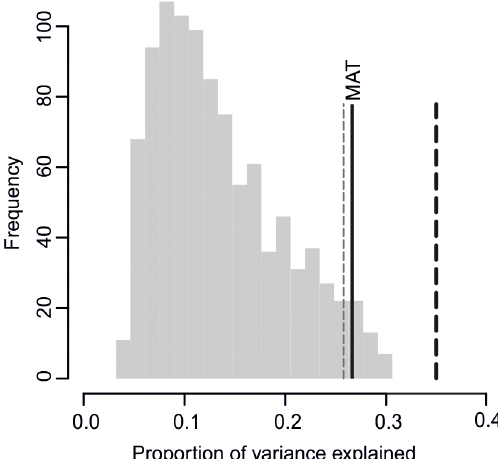
Figure 11. Histogram of the proportion of variance in the chi- ronomid MAT transfer function explained by 999 transfer functions trained on random environmental variables. Solid black line denotes the proportion of variance explained by the chironomid WA inverse MAT transfer function. Black dashed line marks the proportion of variance explained by the first axis of PCA of the fossil data. Grey dashed line marks the 95% variance of the random